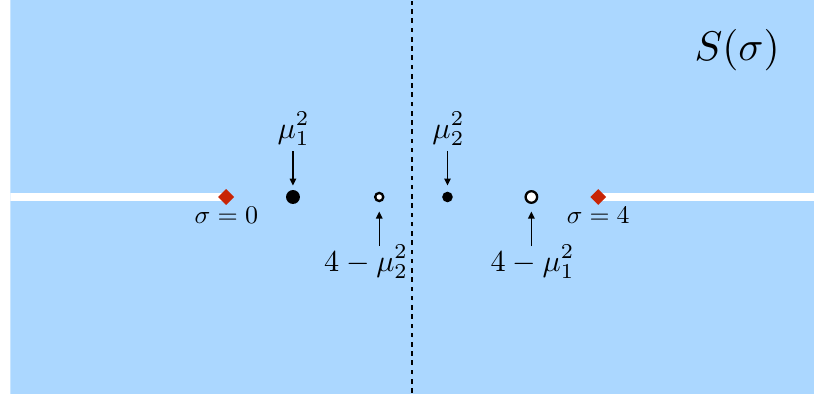
(cid:27) ) = S ( (cid:27) ). (cid:0)